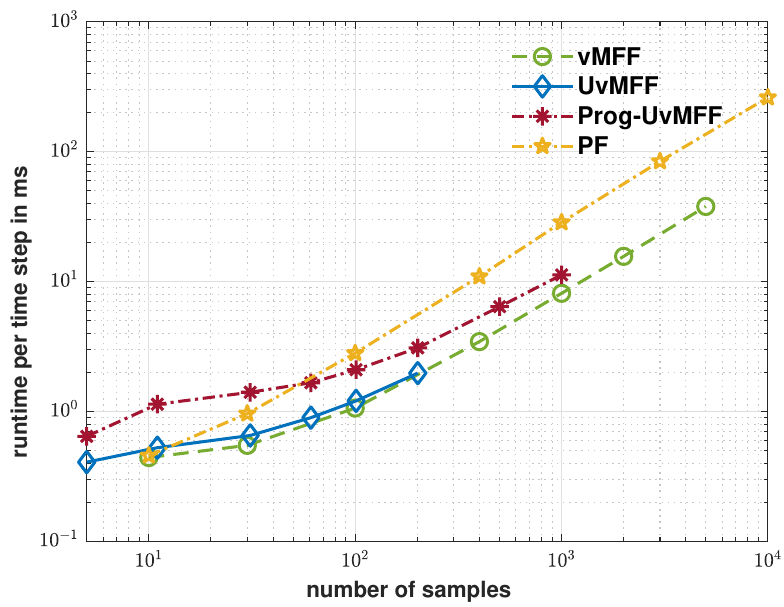
Figure 5. Runtime for each time step in ms over sample size for the evaluated filters.